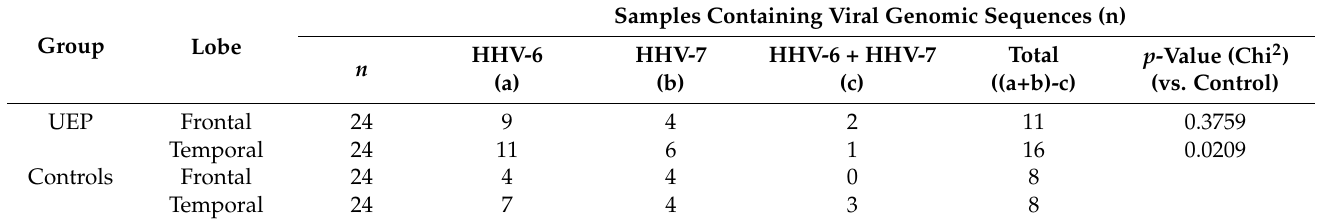
Table 1. The presence of single herpesvirus-6, 7 (HHV-6, -7) genomic sequences and HHV-6, -7 co-infection in tissue DNA samples of the frontal and temporal lobes in the unspecified encephalopathy (UEP) individuals and control group. Samples Containing Viral Genomic Sequences (n) Group Lobe HHV-6 HHV-7 HHV-6 + HHV-7 Total p -Value (Chi 2 ) n (a) (b) (c) ((a+b)-c) (vs. Control) UEP Frontal 24 9 4 2 11 0.3759 Temporal 24 11 6 1 16 0.0209 Controls Frontal 24 4 4 0 8 Temporal 24 7 4 3